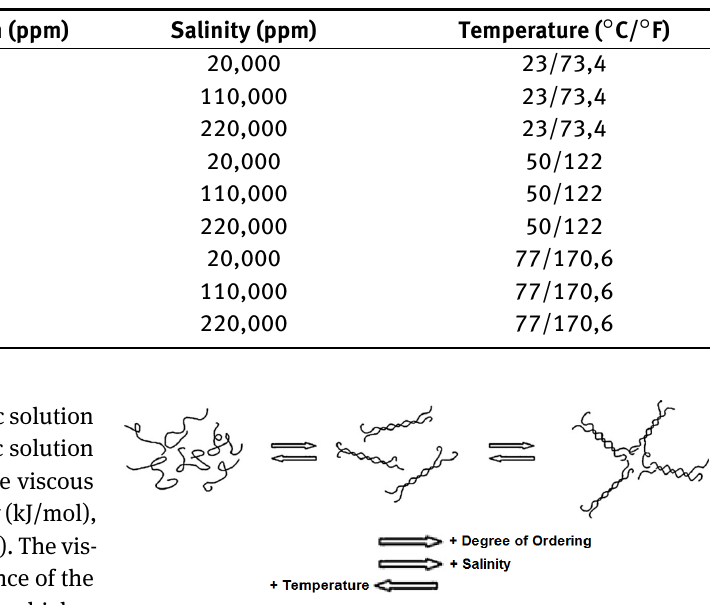
Figure 2: Xanthan gum conformance configuration under tempera- ture and salinity effects. Modified from